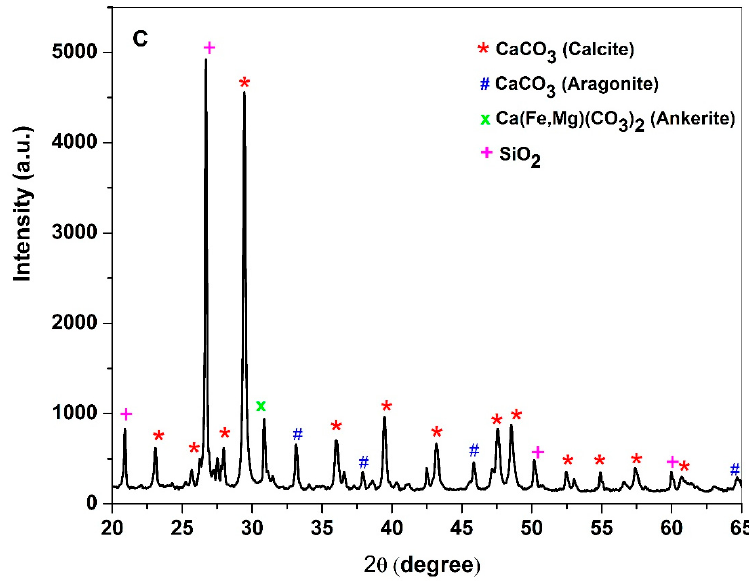
Figure 5. X-ray diffraction pattern for sample C. Table 2. Semiquantitative XRD analysis of A, B, and C mortar